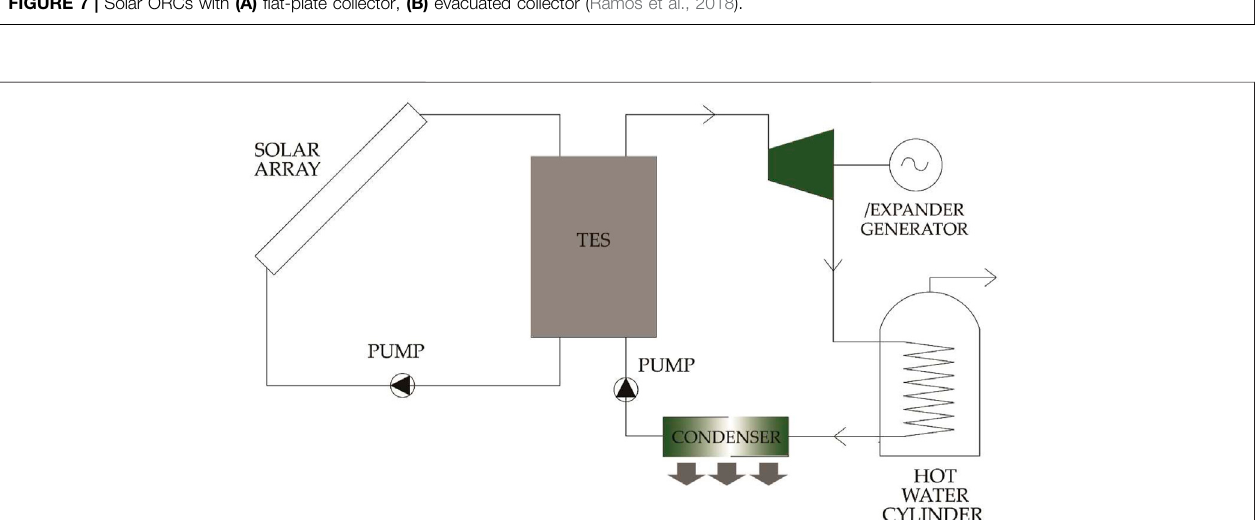
Frontiers in Energy Research |